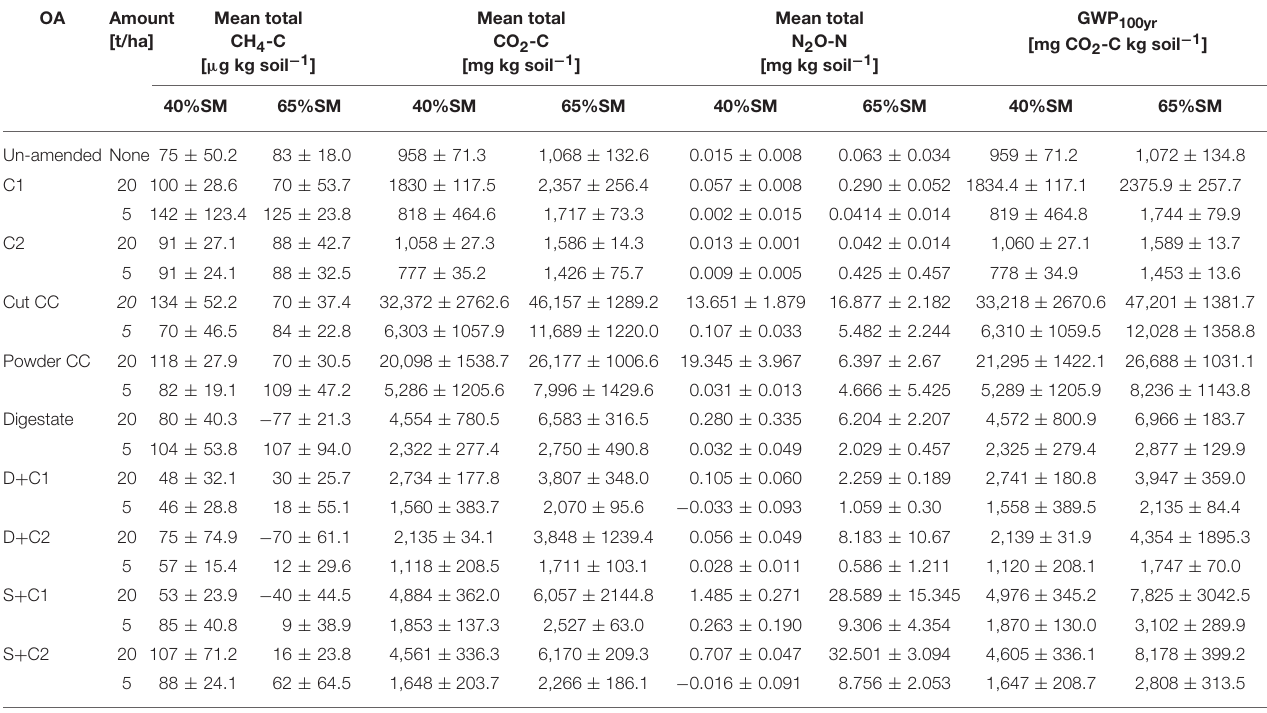
TABLE 2 | Overview of mean total CH 4 . CO 2 , N 2 O, and calculated GWP 100yr values of the different organic amendments, amounts, and soil moisture concentration that were used. OA Amount